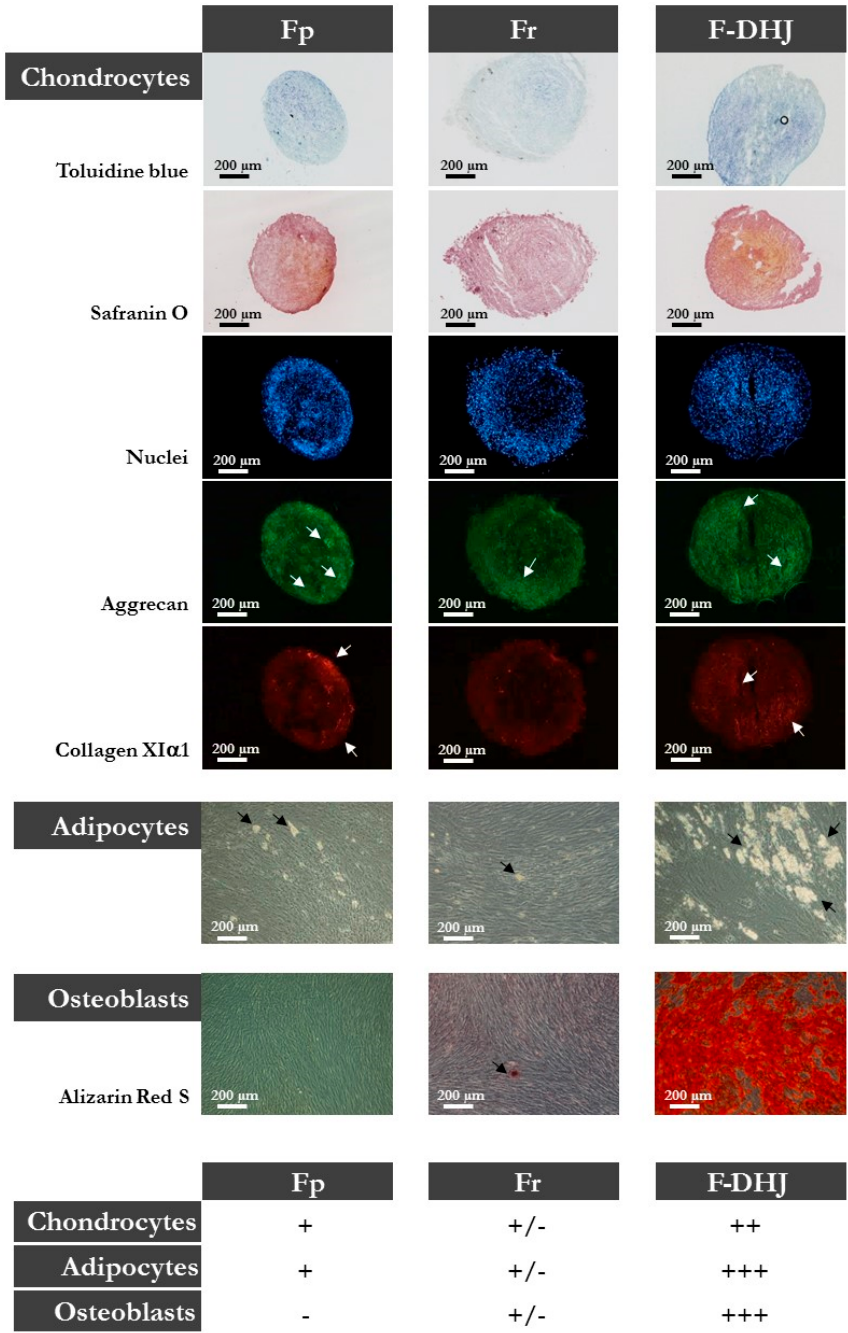
Figure 3. Di ff erentiation capacities of Fp, Fr, and F-DHJ fibroblasts into mesodermal lineages. Samples from 5 independent “young” donors (20, 22, 25, 28, and 31 years old) were tested for their capacity to differentiate into chondrocytes (toluidine blue and safranin O staining, aggrecan (ACAN) and collagen XI α 1 (ColXI α 1) expression, white arrows); adipocytes (presence of cytoplasmic lipid droplets, black arrows); and osteoblasts (alizarin-red staining). Scoring of differentiation capabilities are presented: ( − ) = not present, (+/ − ) = low representation, (++) = frequent representation, and (+++) = major representation. Taken together, these data show that Fp, Fr, and F-DHJ fibroblasts exhibit di ff erent functional